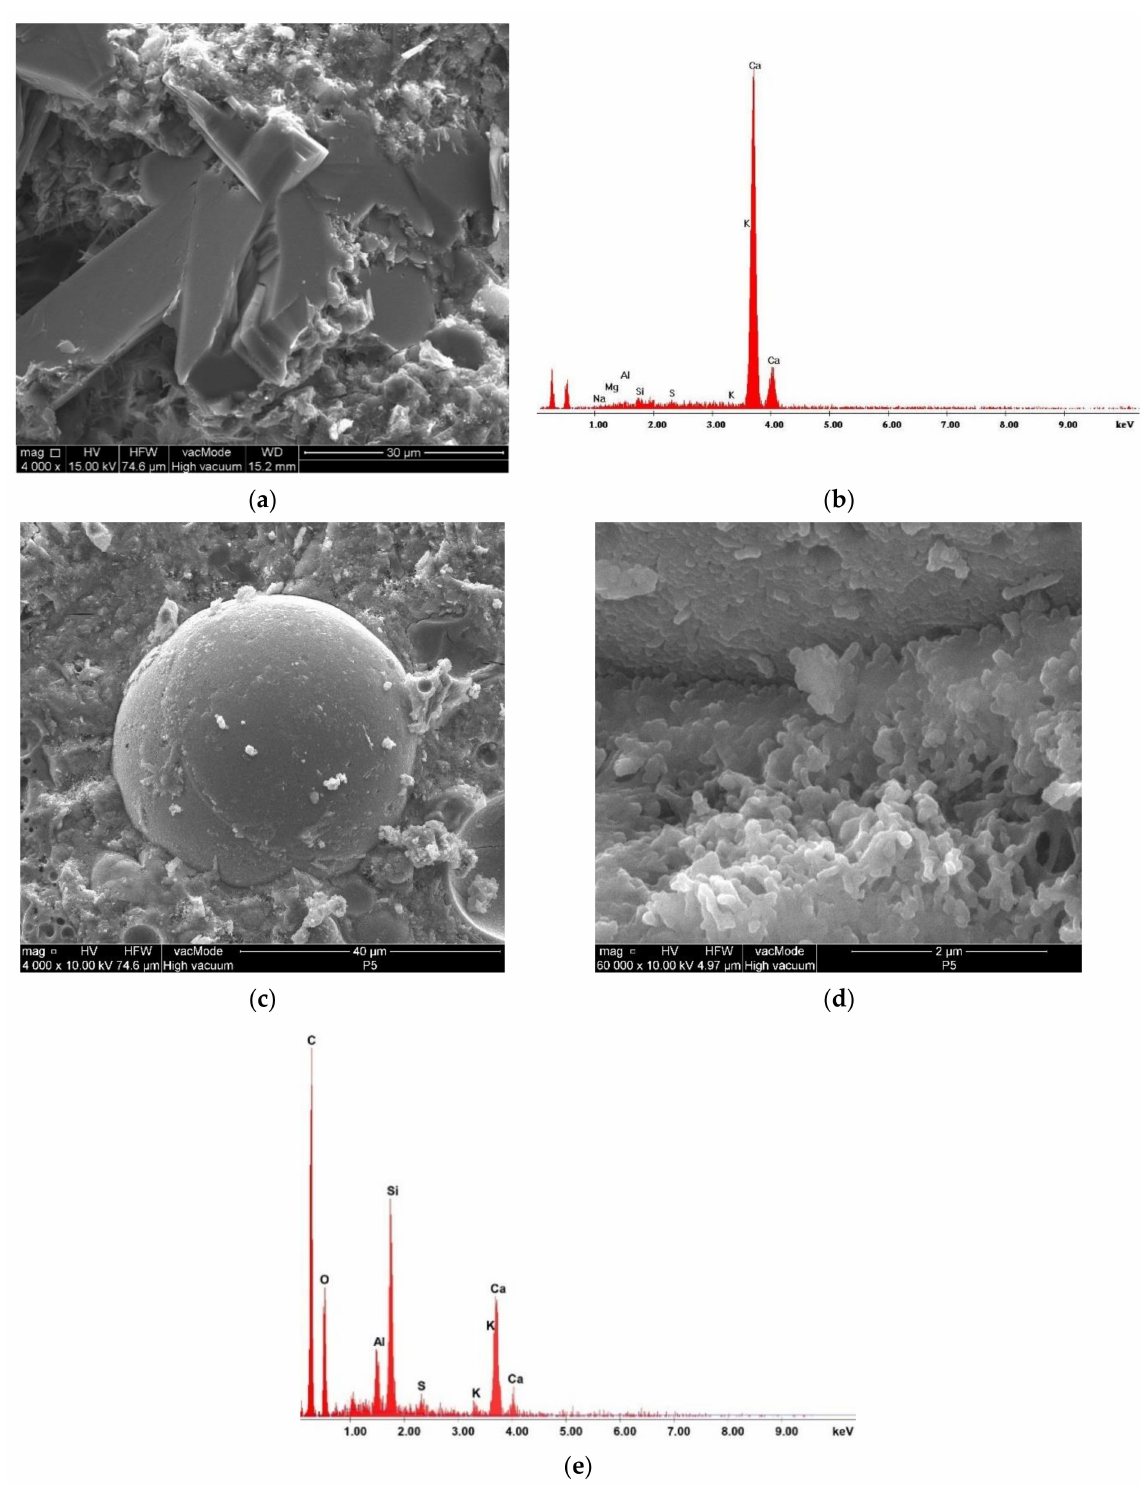
Figure 5. Microstructure and EDS spectra of Portland cement paste: ( a , b ) without SCMs; ( c – e ) containing 15% by mass of GGBFS and 5% by mass of